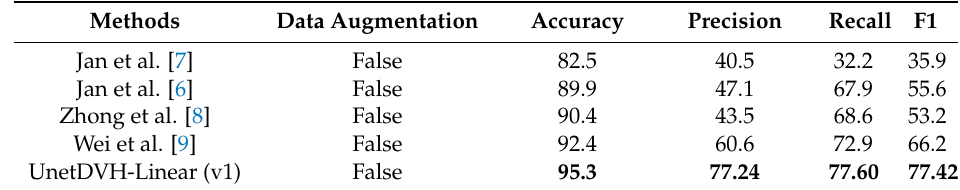
Table 9. Performance of road extraction in Massachusetts Roads Dataset by our method and other approaches (%).